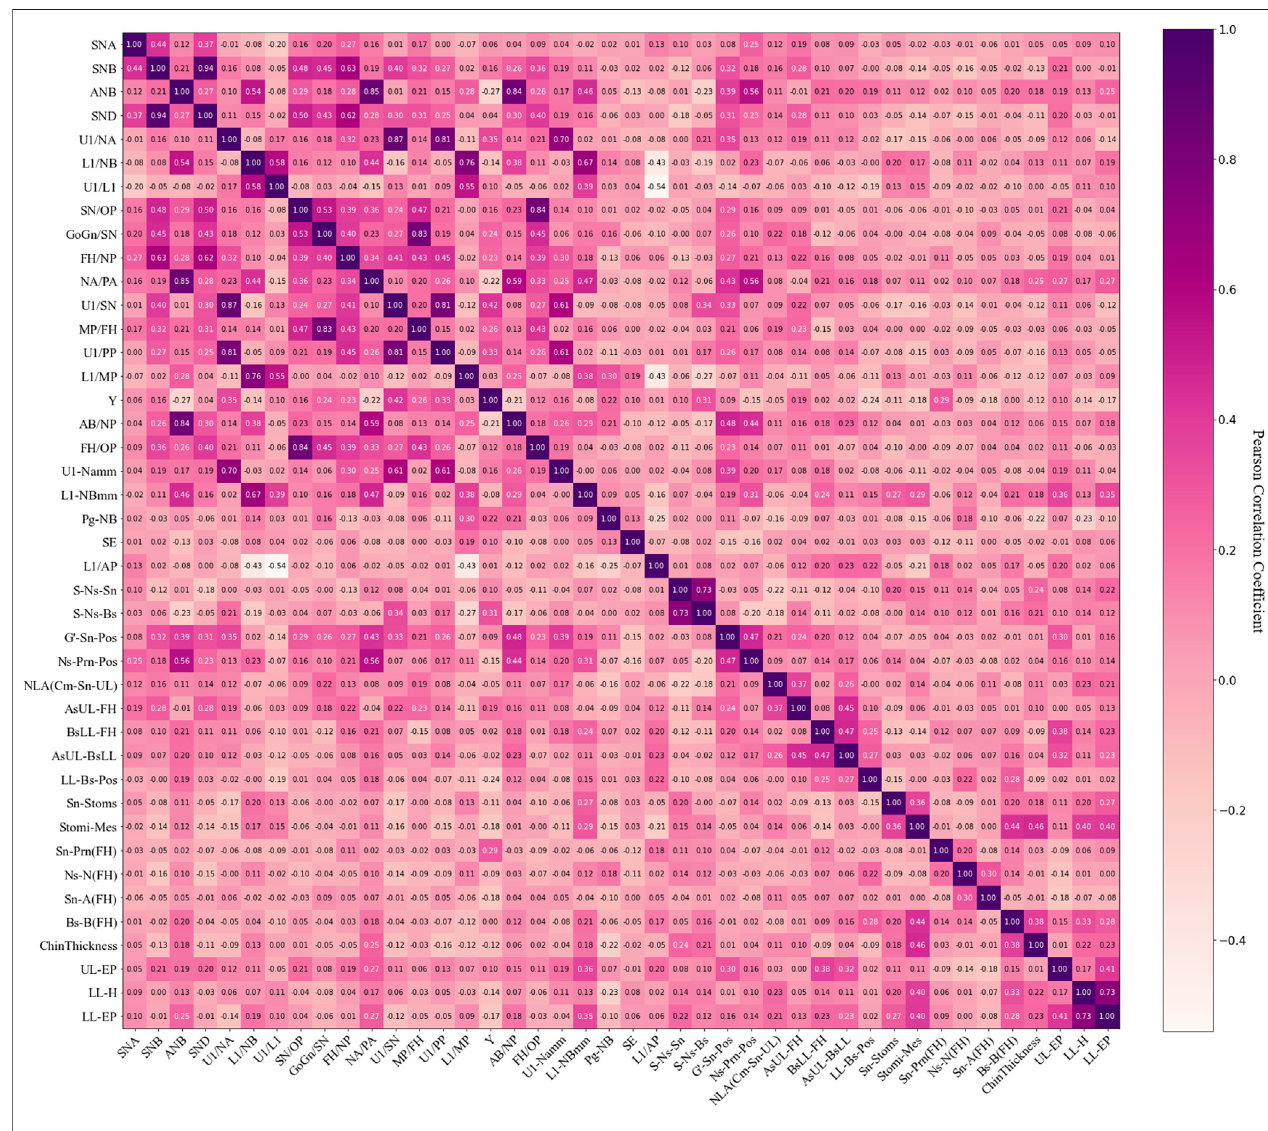
FIGURE 6 | Pearson correlation coef fi cients with 42